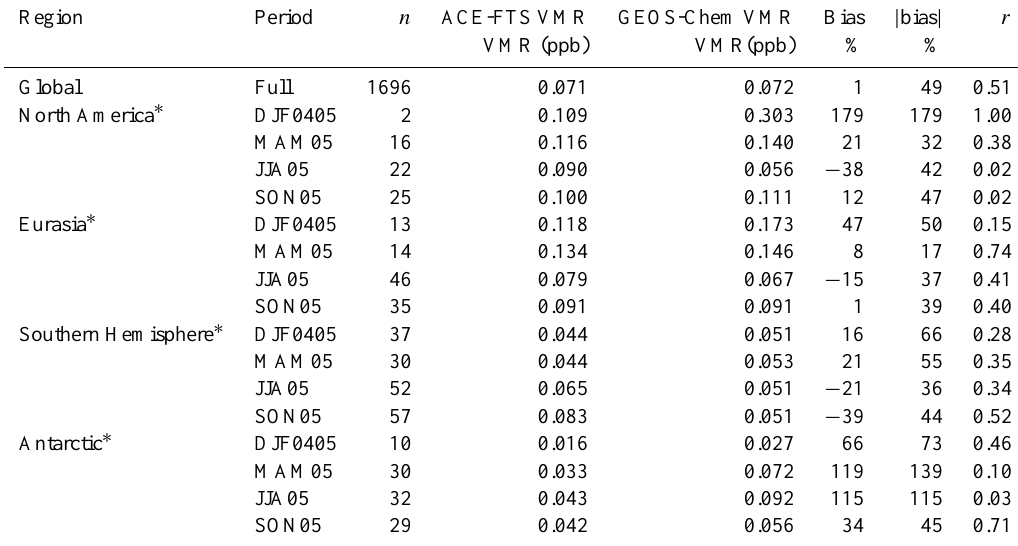
Table 4. Statistical comparison between ACE retrieved C 2 H 2 concentrations and GEOS-Chem output at 8.5km altitude; VMRs are expressed in ppb: n is the number of data taken into account, bias is the Mean Bias as defined by Eq. (1), | bias | is the Mean Absolute Bias as defined by Eq. (2) and r is the correlation